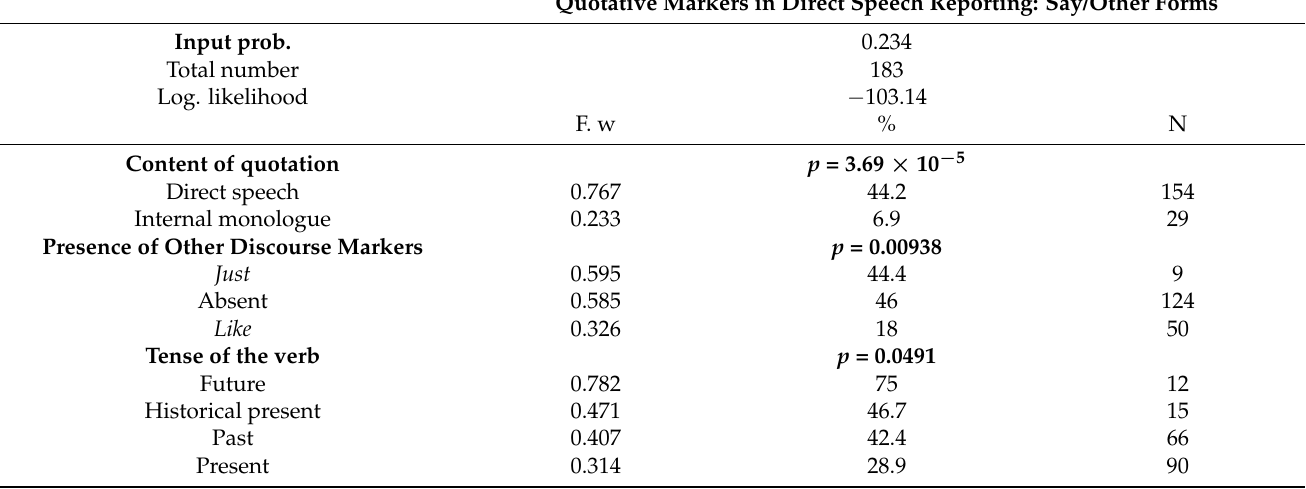
Table 6. Statistical results for all